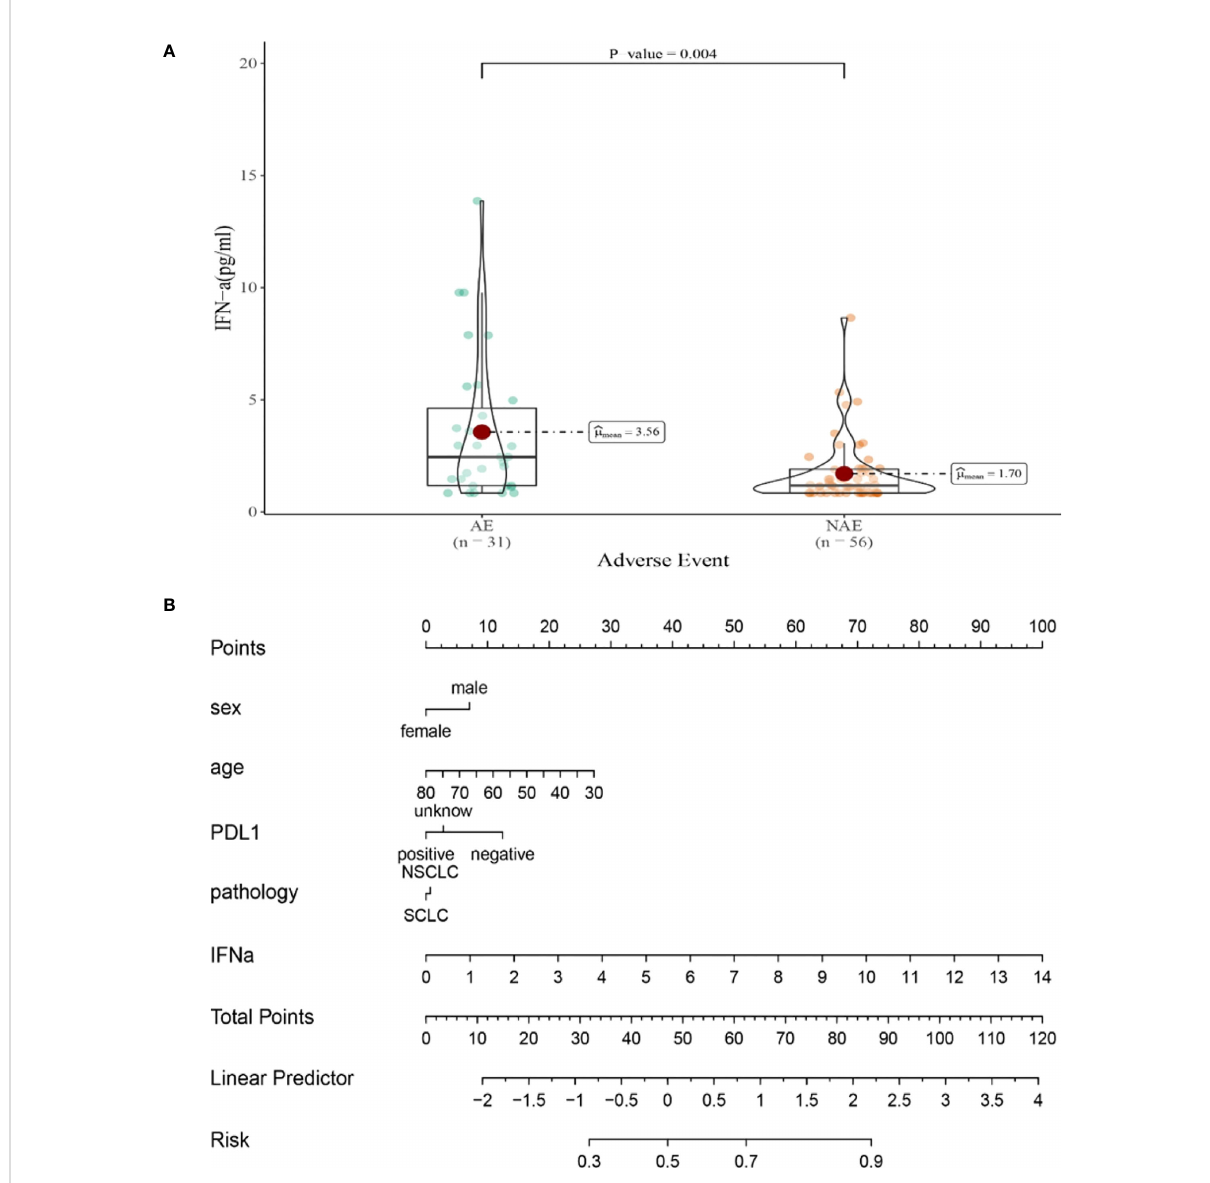
FIGURE 7 (A) Differences in IFN- a levels after the fi rst cycle therapy between AE and NAE; (B) The nomogram of irAEs prediction based on logistic multivariate